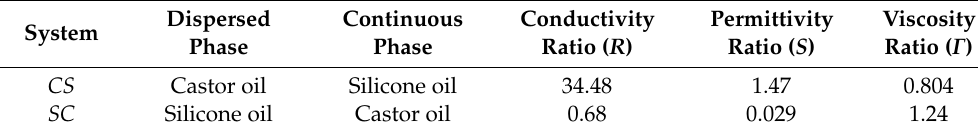
Table 2. Liquid systems used in the